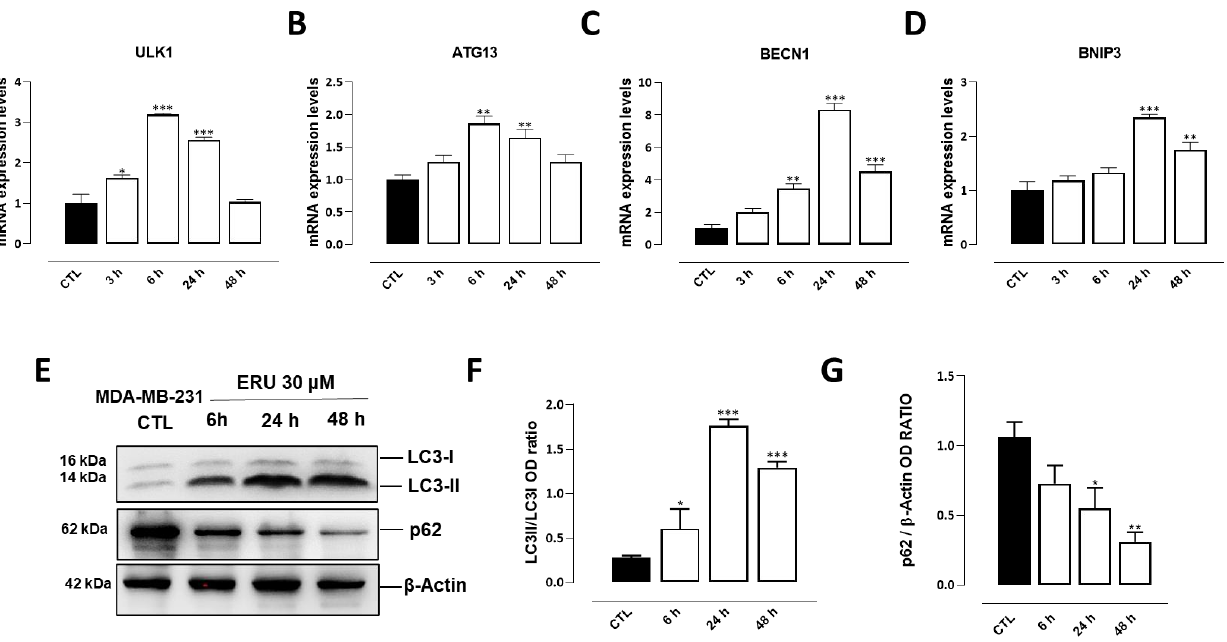
Figure 2. ERU induces autophagy in MDA-MB-231 cells. ( A – D ) mRNA expression levels of ULK1, ATG13, BECN1, and BNIP3 in MDA-MB-231 cells following the treatment with ERU (30 µ M) for 3, 6, 24, and 48 h; ( E ) representative blots and quantitative analysis of LC3 ( F ) and p62 ( G ) proteins measured in MDA-MB-231 following the treatment with ERU (30 µ M) for 6, 24, and 48 h. β -Actin was detected as a loading control. Each data point was obtained from three independent determinations for each experimental condition. * p < 0.05; ** p < 0.01; *** p < 0.001 vs. CTL.